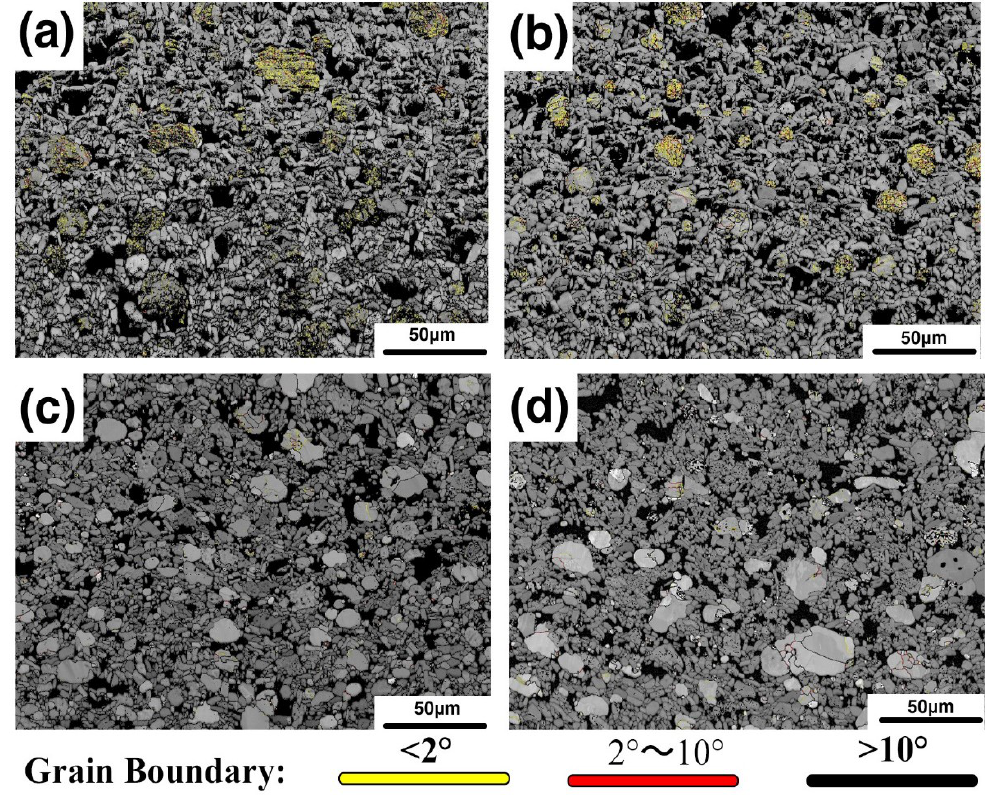
Figure 10. The grain boundary distribution of samples B1 ( a ), B2 ( b ), B3 ( c ), and B4 ( d ).